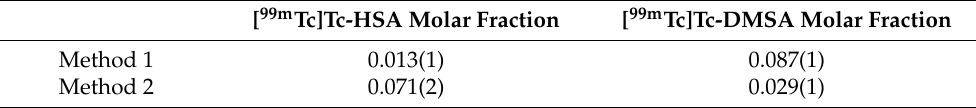
Table 5. Amount of 99m Tc atoms bound to HSA or to DMSA reported as molar fraction. Mean (SD).